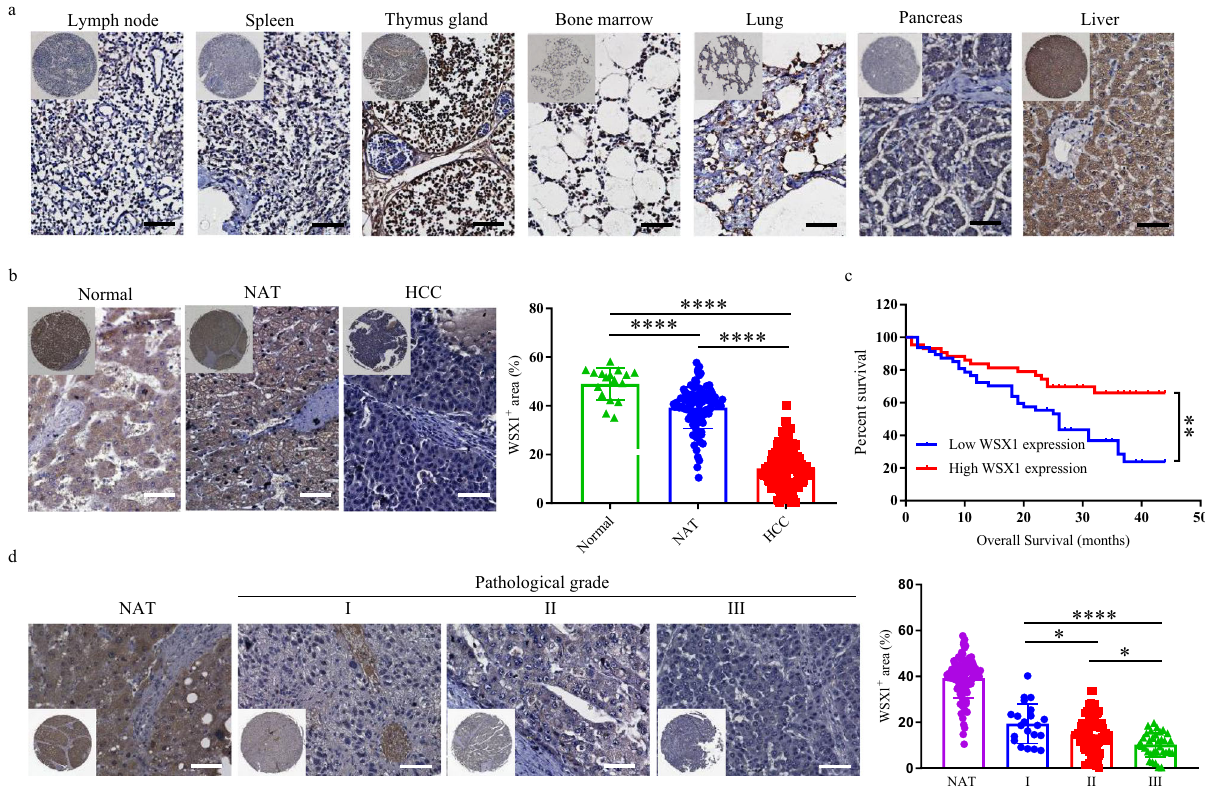
Fig. 1 WSX1 is highly expressed in normal hepatocytes, and its downregulation in HCC correlated with poor prognosis. a Immunohistochemical (IHC) staining of WSX1 in a human normal tissue microarray (TMA, FDA662a). The images shown are representatives for results of 2 individuals. b IHC staining of WSX1 in HCC TMAs (BC03116a and HLiv-HCC180Sur-03), including human normal liver tissue ( n = 17), NAT ( n = 103, P < 0.0001 compared to normal liver tissue), and HCC ( n = 130, P < 0.0001 compared to both normal liver tissue and NAT) samples. Statistical analysis results are based on quanti fi cation